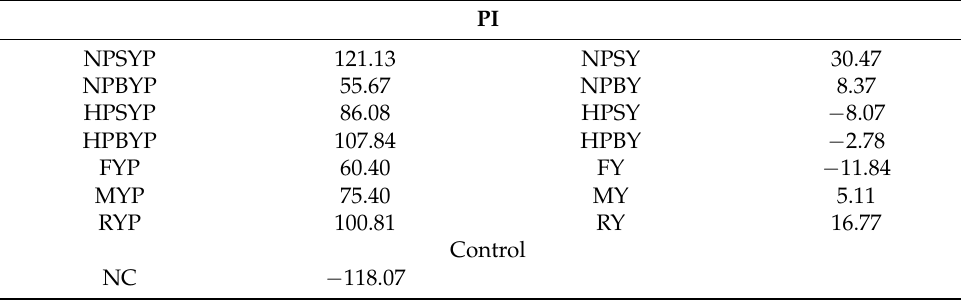
Table 2. The PI values of yams and yam